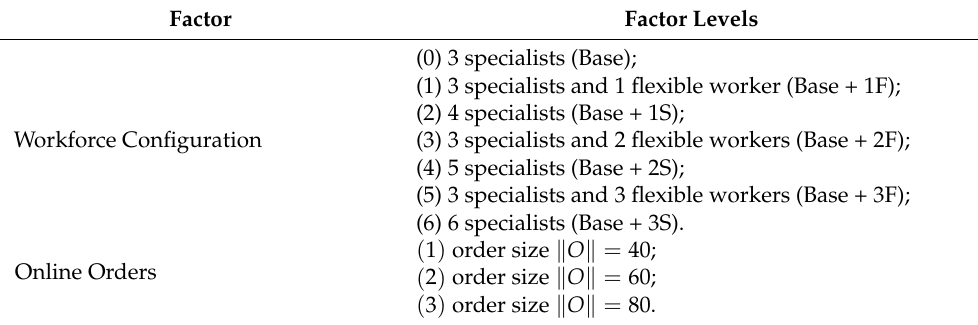
Table 4. Experiment